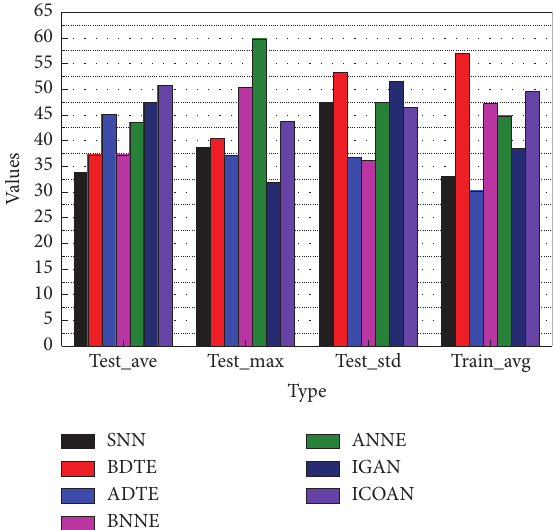
Figure 6: Comparison of classification